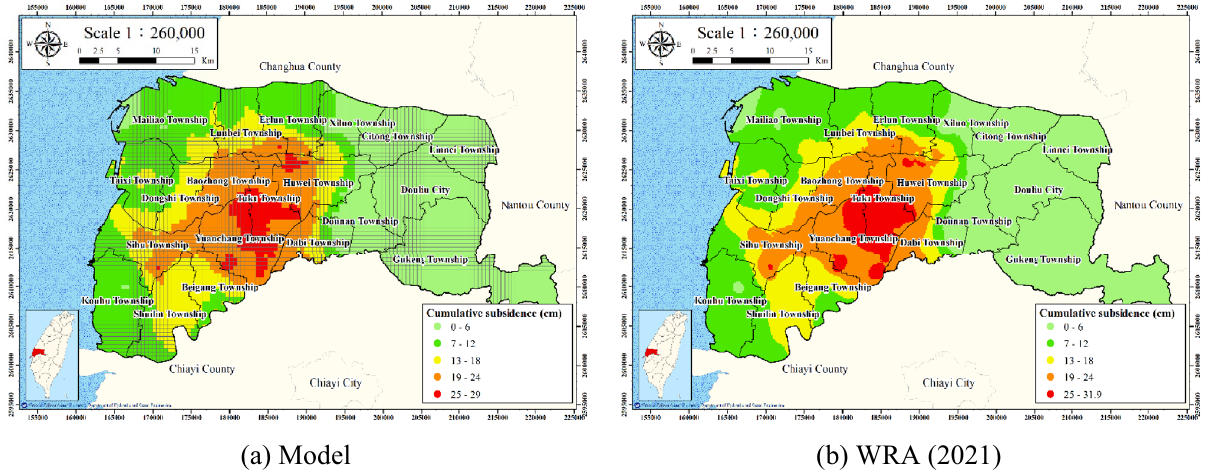
Figure 17. Land subsidence in Yunlin County. This figure was created using ArcGIS 10.6.1